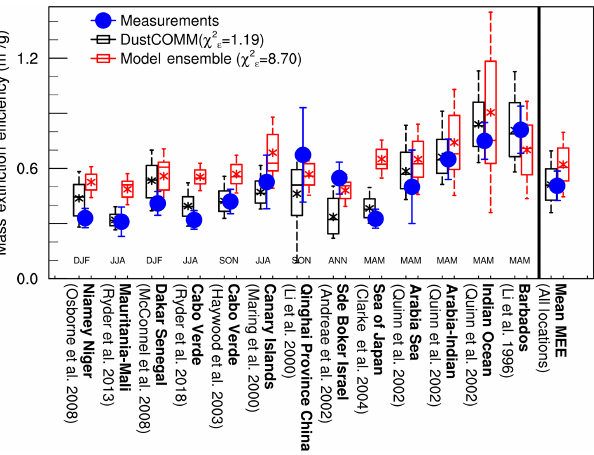
Figure 8. Comparison of measurements (blue dots) of dust MEEs (m 2 g − 1 ) against column-integrated DustCOMM (black bars) and model ensemble (red bars) estimates. Vertical bars on the mea- surements represent reported uncertainty. For the DustCOMM and model ensemble estimates, the black and red boxes show 1 standard error, whereas the vertical dotted lines show the 95% confidence in- terval; the middle horizontal bar and star show the median and mean values, respectively. The DustCOMM and model ensemble values are season-averaged values corresponding to the observation time period (see Table 2 for details). These seasons are labelled DJF – Dec–Feb, MAM – Mar–May, JJA – Jun–Jul, and SON – Sep–Nov; ANN represents an annually averaged value. The model ensemble MEE is calculated from the ratio between individual model dust aerosol optical depth and the dust mass loading, while the Dust- COMM MEE is calculated using the constrained dust size distribu- tions and single-particle extinction efficiency that takes into account the asphericity of dust aerosols. χ 2 (cid:15) is the reduced chi-squared value (Eq. 10b) and quantifies the performance of a model in representing observations (e.g. Andrae et al.,